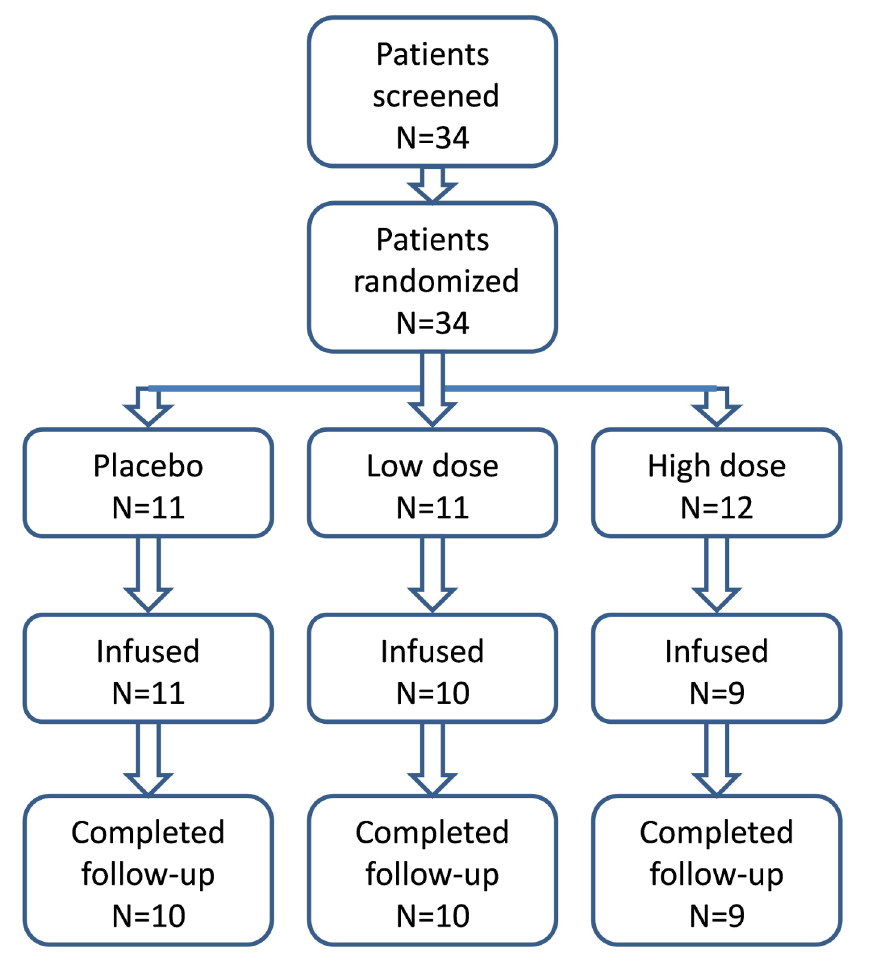
Fig 1. Patient disposition. Low dose = 1x10 6 AdMSCs/Kg; High dose = 4 x 10 6 AdMSCs/Kg.